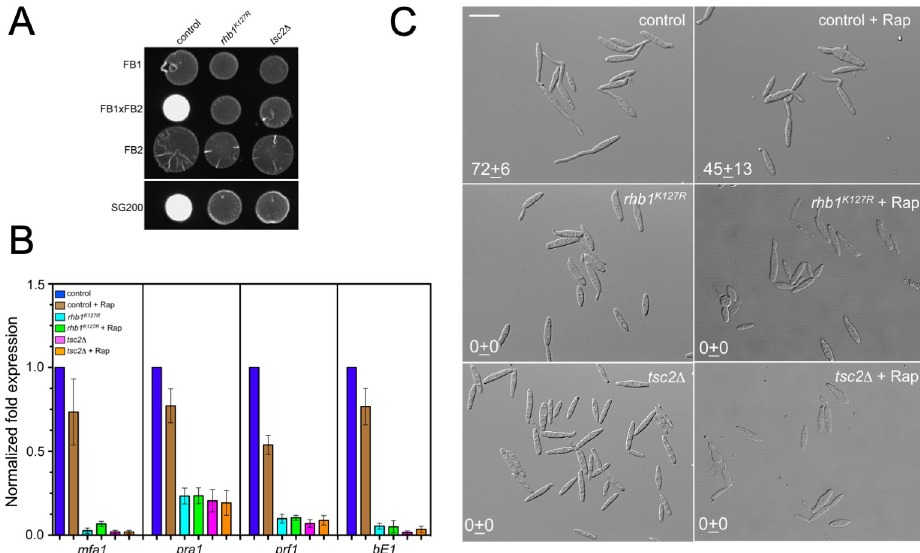
Fig 6. Forced activation of Rheb resulted in the absence of pheromone response. (A) Strains carrying the Rheb- activating mutations cannot form infective filaments. Control and the indicated mutant strains were spotted on minimal ammonium media charcoal plates and incubated for 24 h at 28˚C. The white fuzzy colonies reflect the formation of b -dependent filaments. (B) qRT-PCR for the indicated genes from control (FB1) and mutant cells incubated for 6 hours in minimal ammonium media in the presence of synthetic a2 pheromone (2.5 μ g/ml). Rap indicated the addition of 1 μ g/ml rapamycin. Values are referred to the expression of each gene in the control strain. Each column represents the mean value of three independent biological replicates. Error bars represent the SD. (C) Cell images from cultures of (B) showing the absence of conjugation tubes in mutant strains. Bar: 15 μ